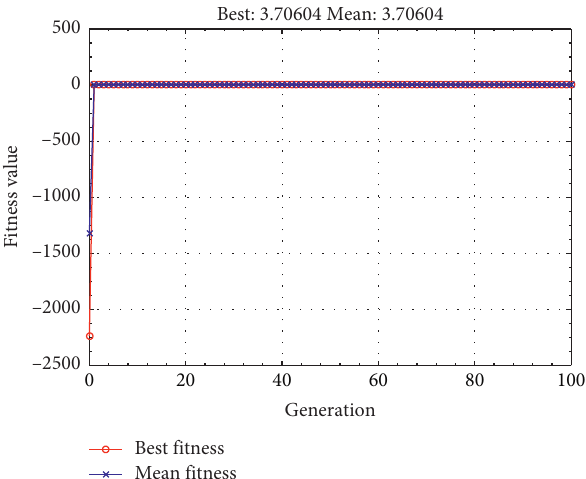
spectrum via FFT. 2 Best: 3.70604 Mean: 3.70604